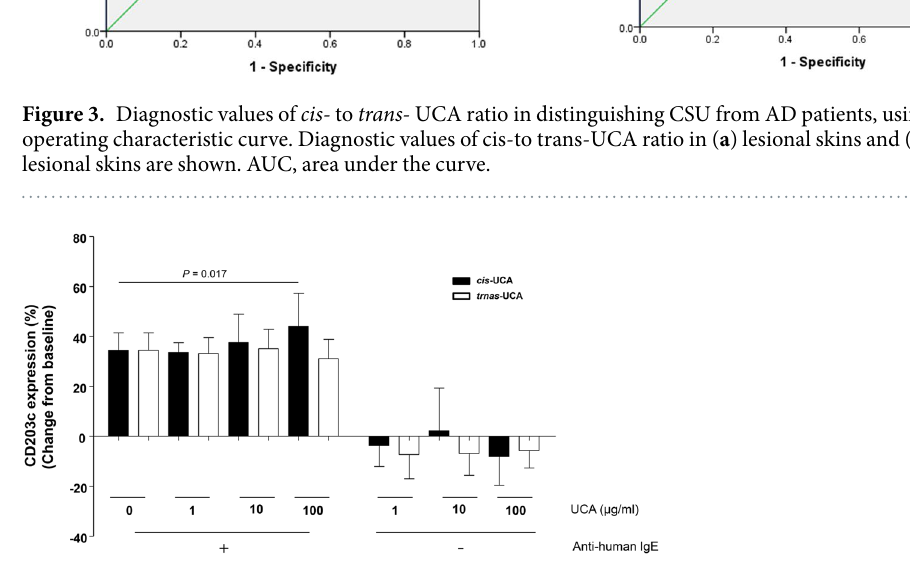
Figure 4. Effects of cis- and trans- UCA on peripheral blood basophil activation. Basophils from eight atopic subjects were treated simultaneously with cis- and trans- UCA and with anti-IgE stimulation. Basophil activation was measured by surface CD203c expression using flow cytometry. Changes in the percentages of CD203c expressing basophils from baseline (34.5 ± 7%), where neither anti-human IgE nor UCA was treated, are presented. P values were obtained by the Wilcoxon signed-ranks